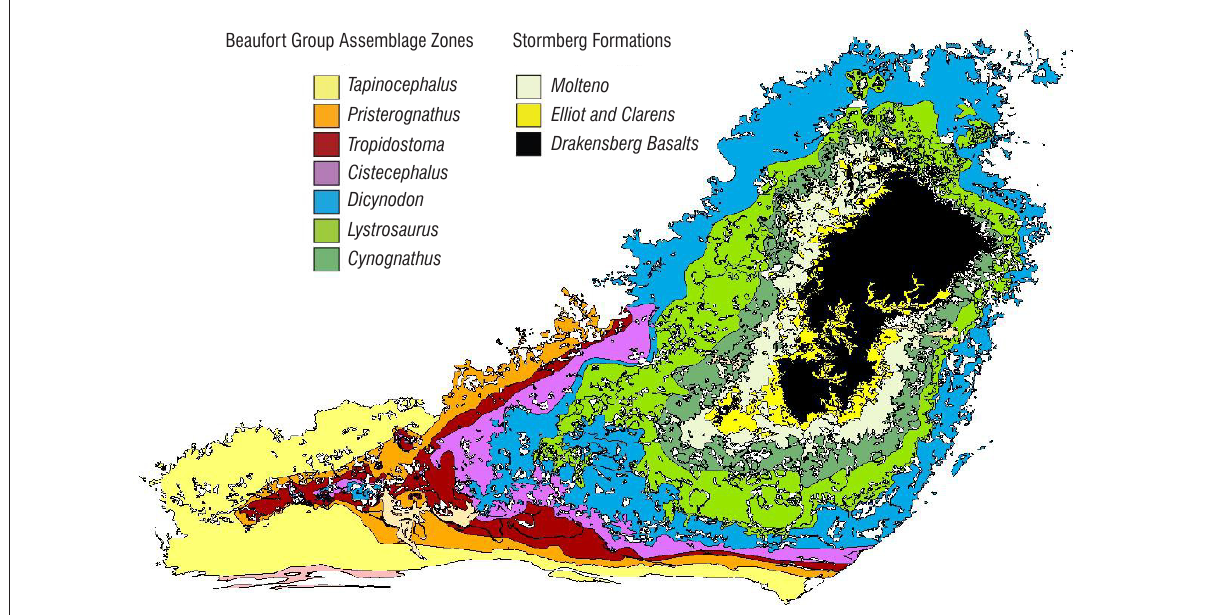
Figure 2: Defined biostratigraphic map of the Beaufort Group, Karoo Supergroup of South Africa – produced through the application of GIS